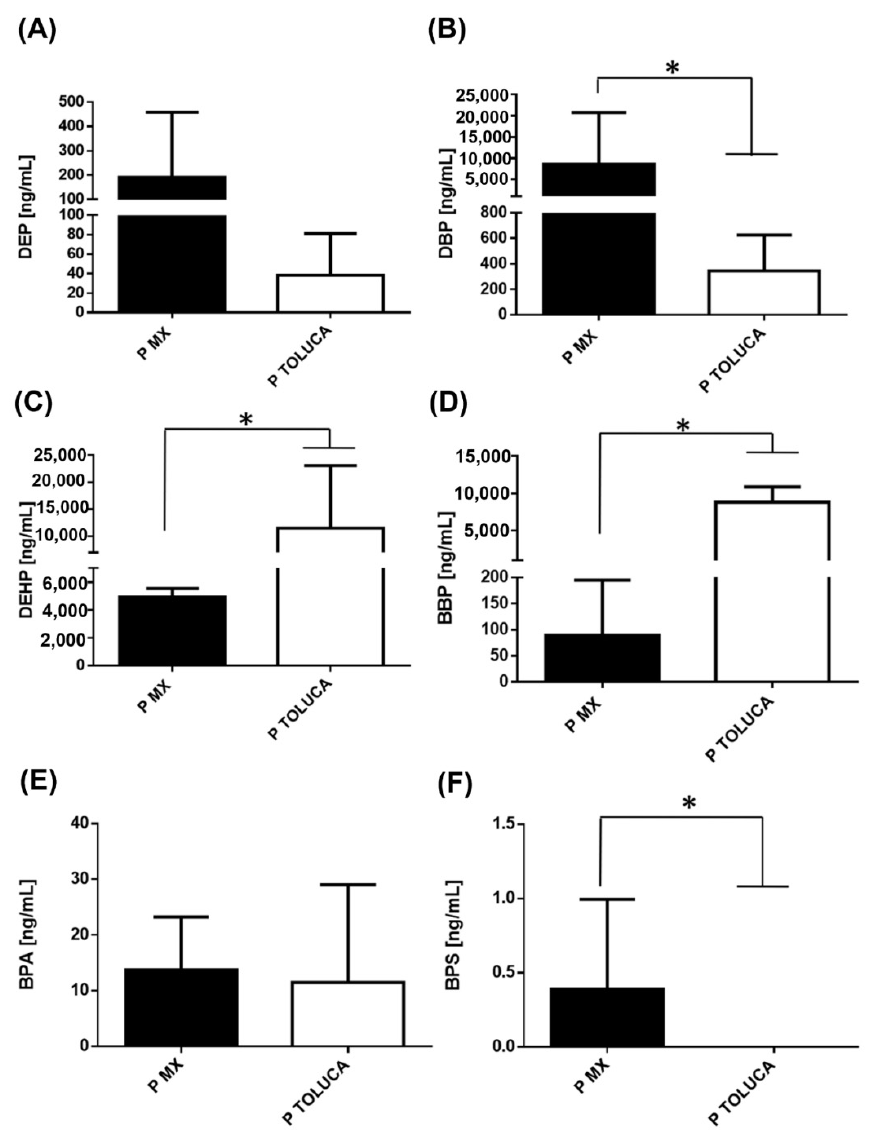
Figure 2. Levels of phthalates and bisphenols in BC cases. Serum concentration levels of phthalates ( A ) DEP, ( B ) DBP, ( C ) DEHP, ( D ) BBP, ( E ) BPA, and ( F ) BPS were measured in BC patients (P) from Mexico City (14 subjects/black bar) and Toluca City (32 subjects/white bar). Bars represent the mean ± S.D. * p < 0.05 was considered statistically significant.